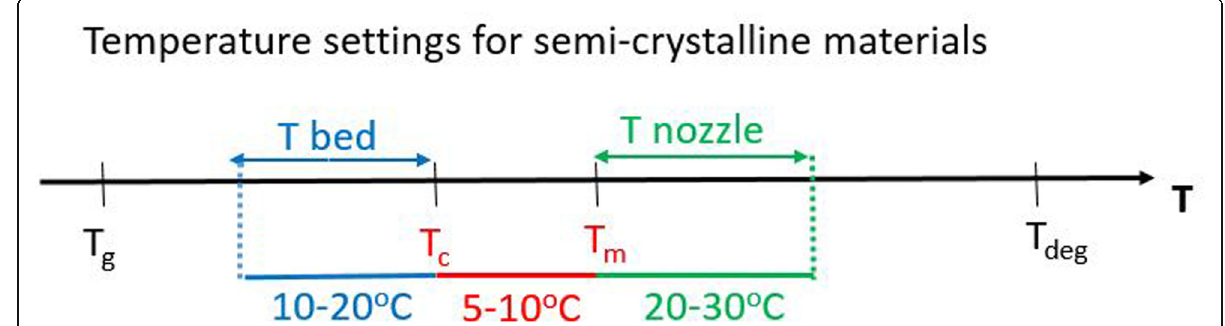
Fig. 4 FDM temperature settings for semi-crystalline polymers and their